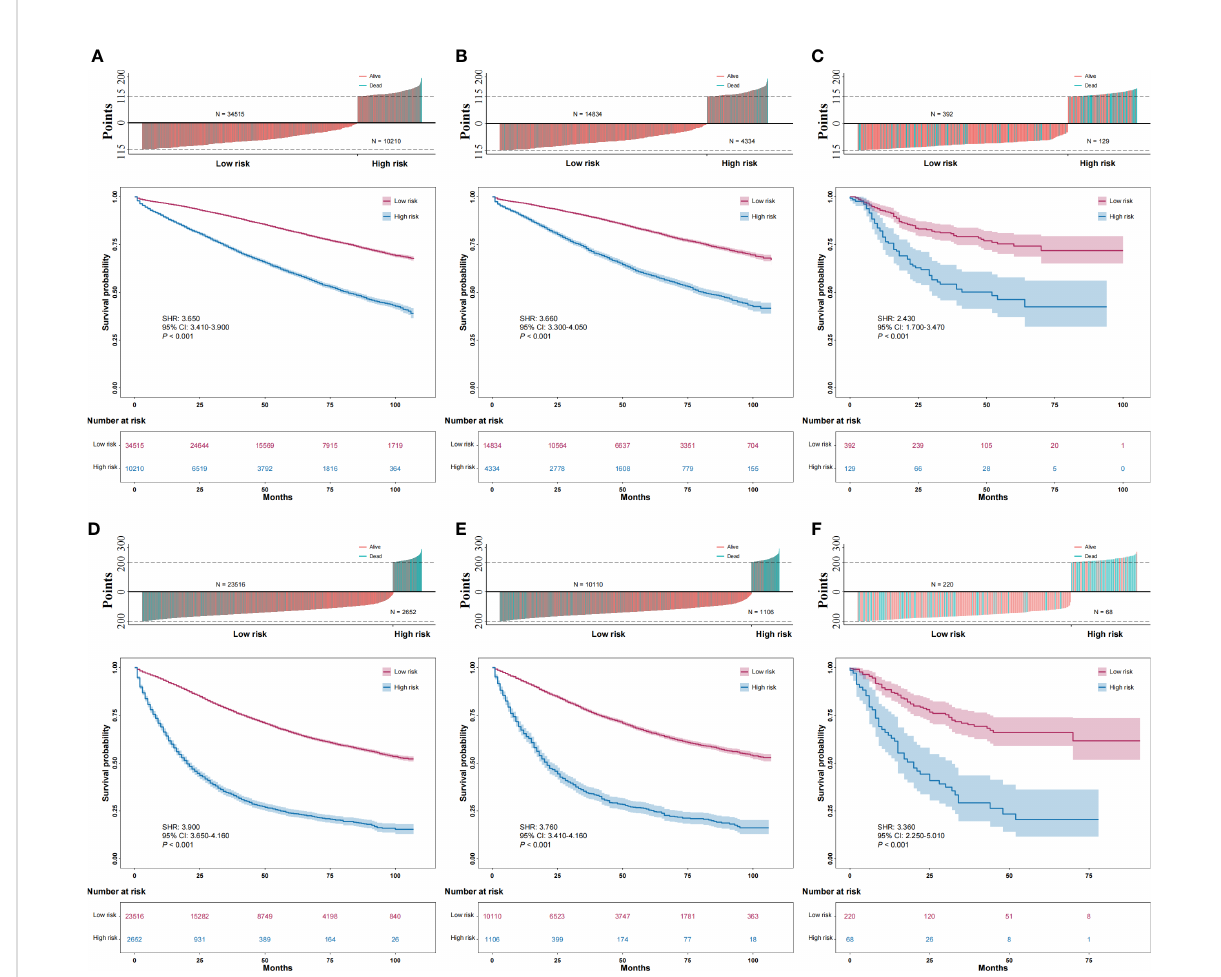
FIGURE 5 Distribution of total score for patients and survival and comparison of the cancer-speci fi c survival of high-risk and low-risk patients. (A) : training data sets of the stage I/II group; (B) : internal validation data sets of the stage I/II group; (C) : external validation data sets of the stage I/II group; (D) : training data sets of the stage III group; (E) : internal validation data sets of the stage III group; (F) : external validation data sets of the stage III